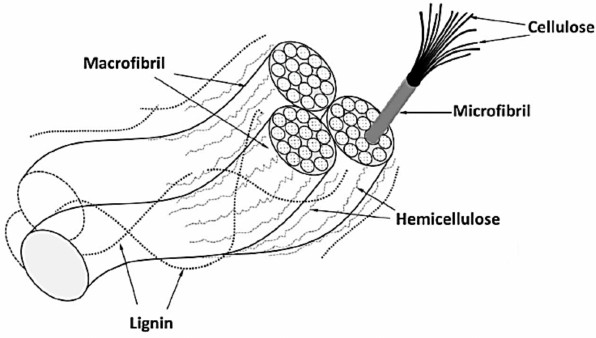
Figure 1. Compositions of natural